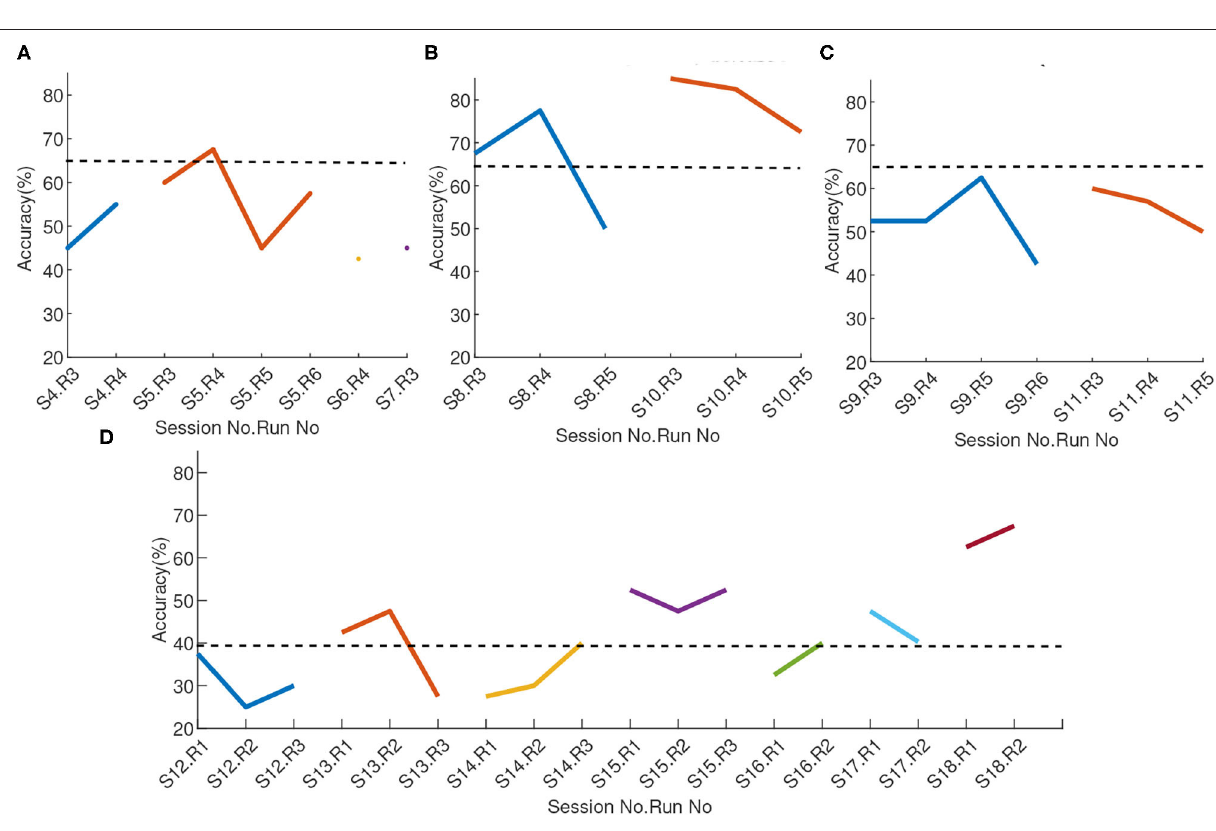
for a significance level of α = 0.05 and for 10